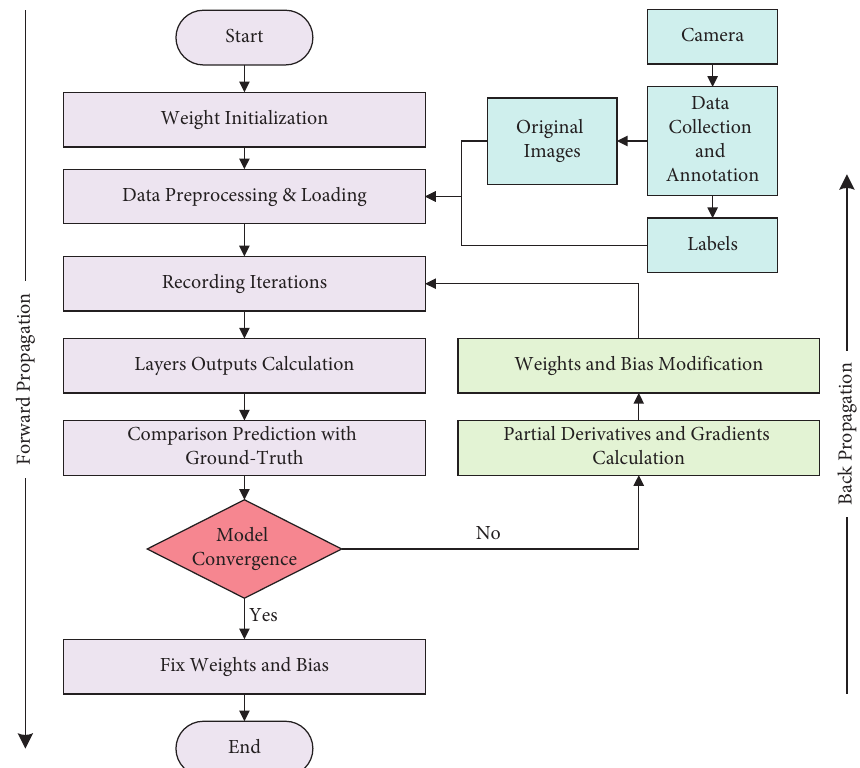
Figure 2: Framework of deep learning-based lane detection